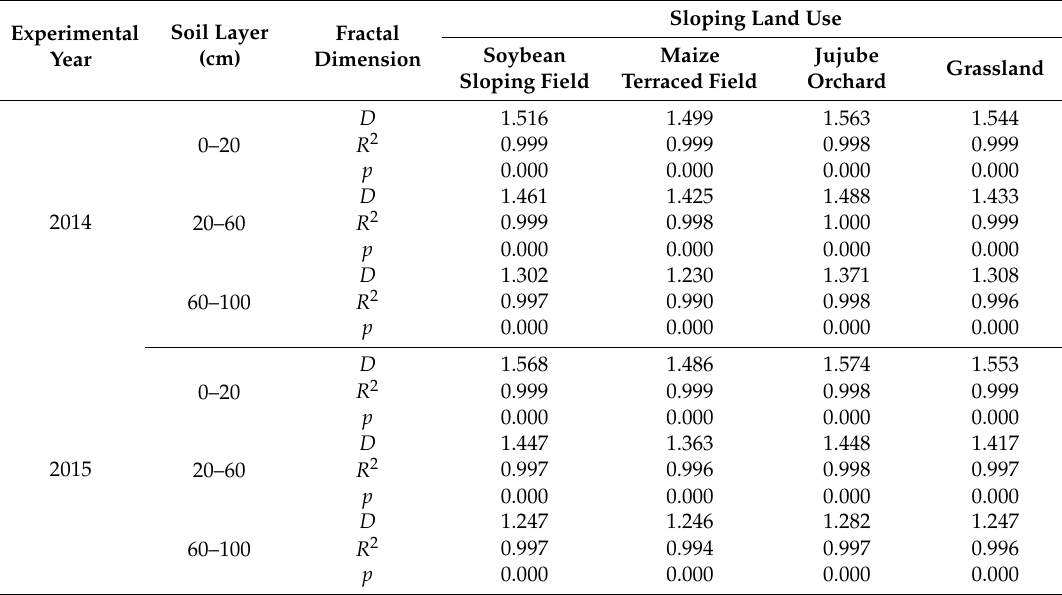
Table 6. Fractal dimension of soil temperature in 0–20 cm, 20–60 cm, and 60–100 cm soil layers under di ff erent sloping land uses during the 2014 and 2015 growing seasons.